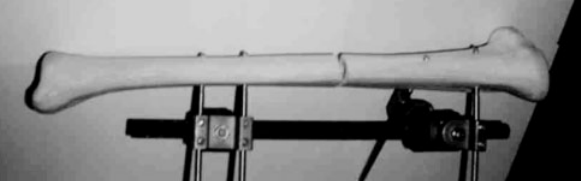
Figure 3 Bone fixation devices constructed of a hex-bar fixed in the bone parts using four long screw